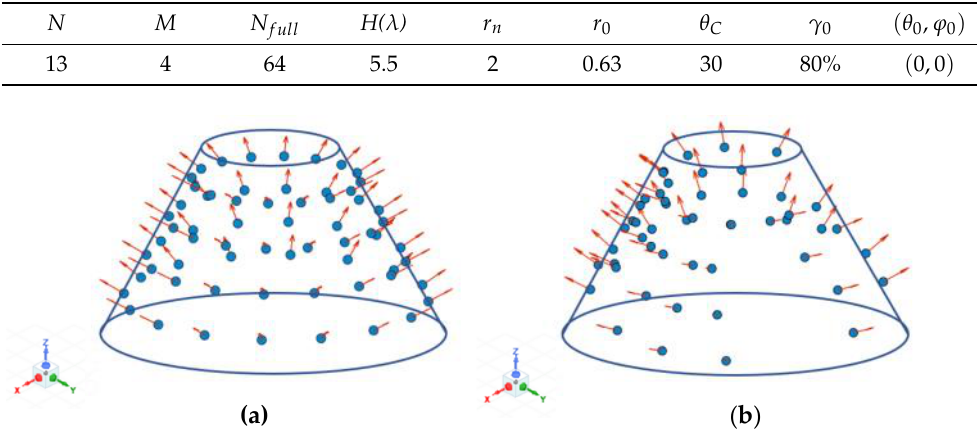
Table 3. The Optimal Placement of the Example Array (Unit: mm).